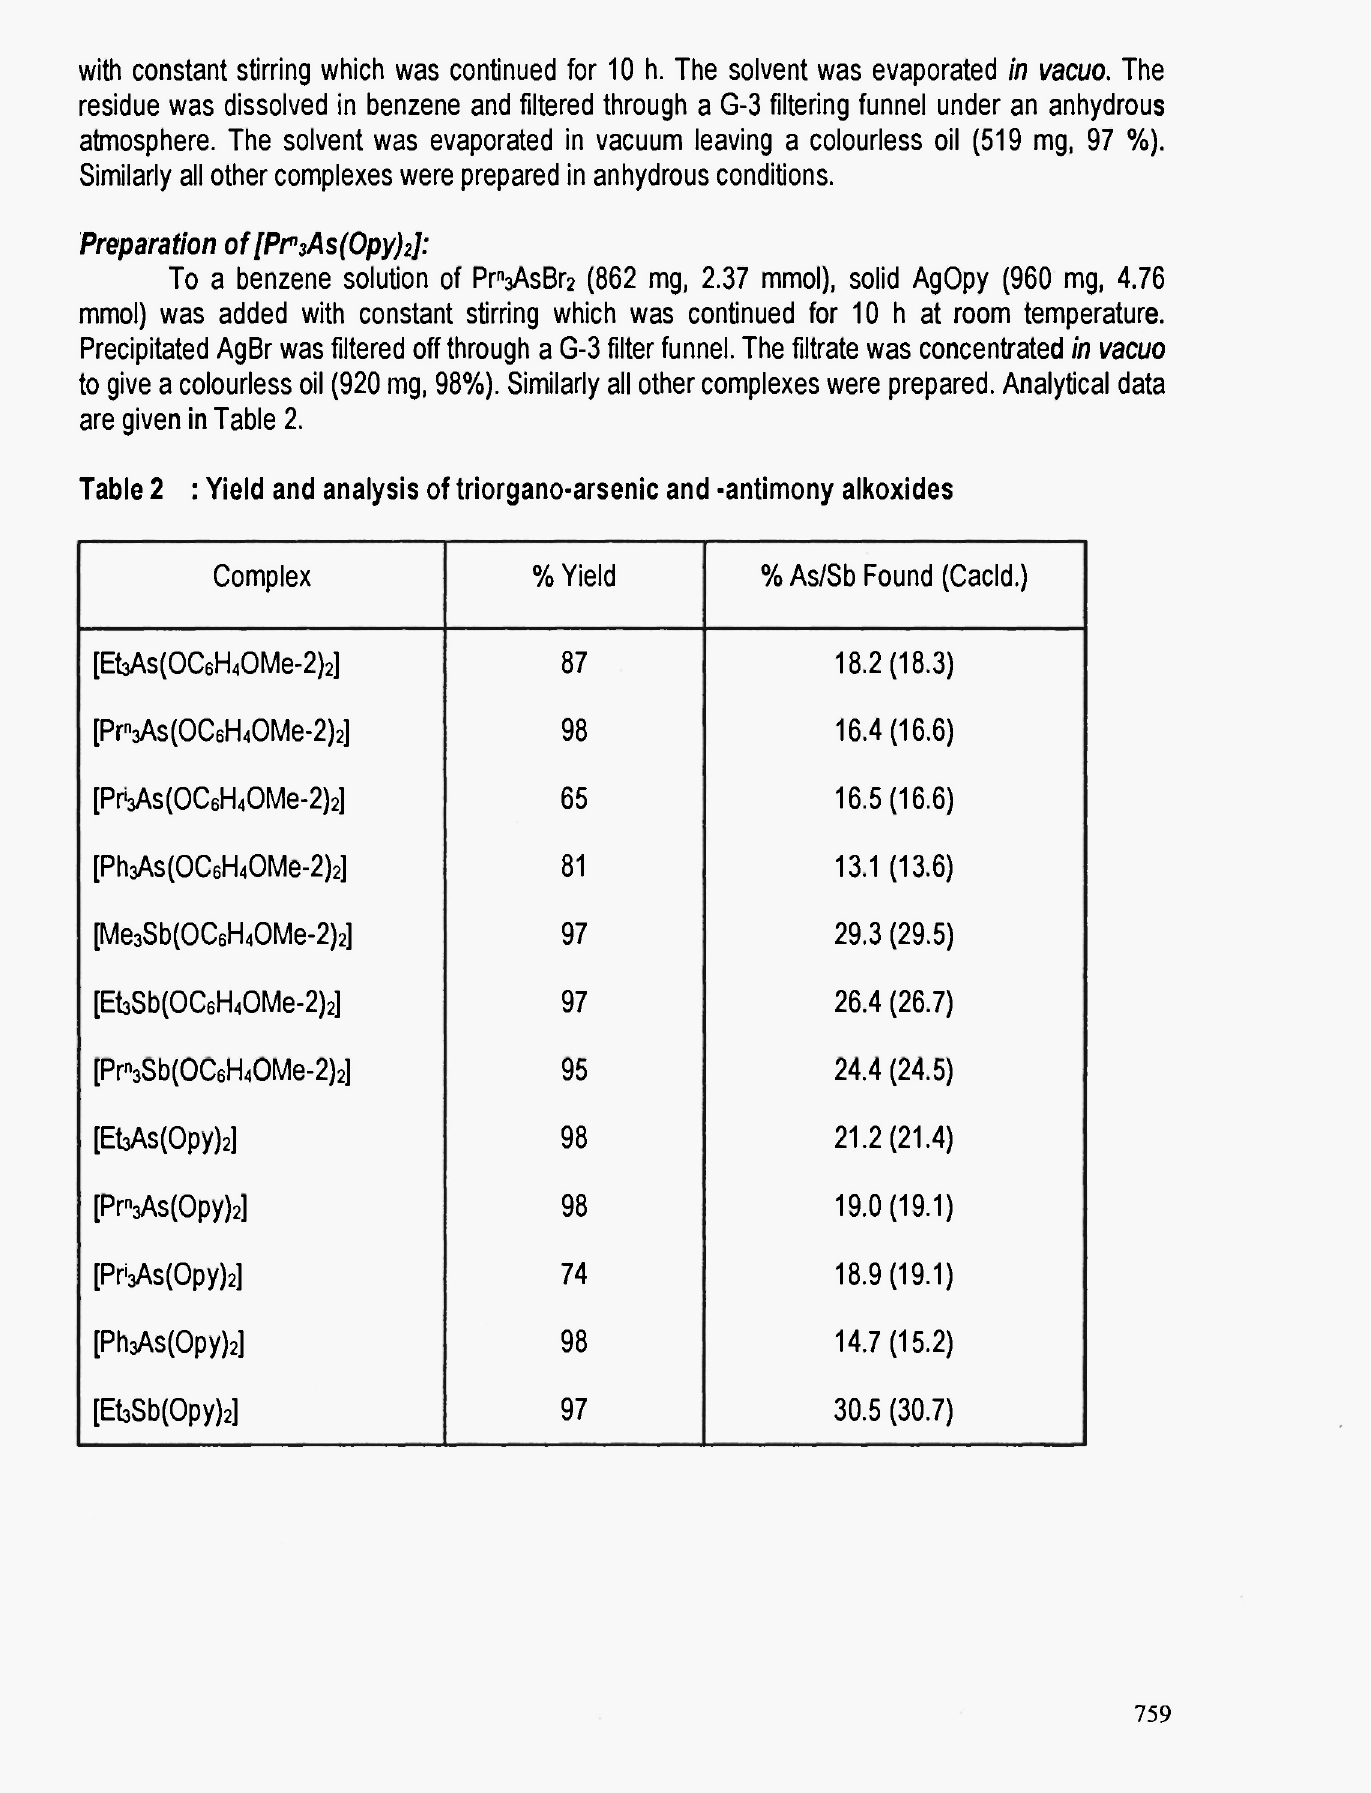
: Yield and analysis of triorgano-arsenic and -antimony alkoxides Complex % Yield % As/Sb Found